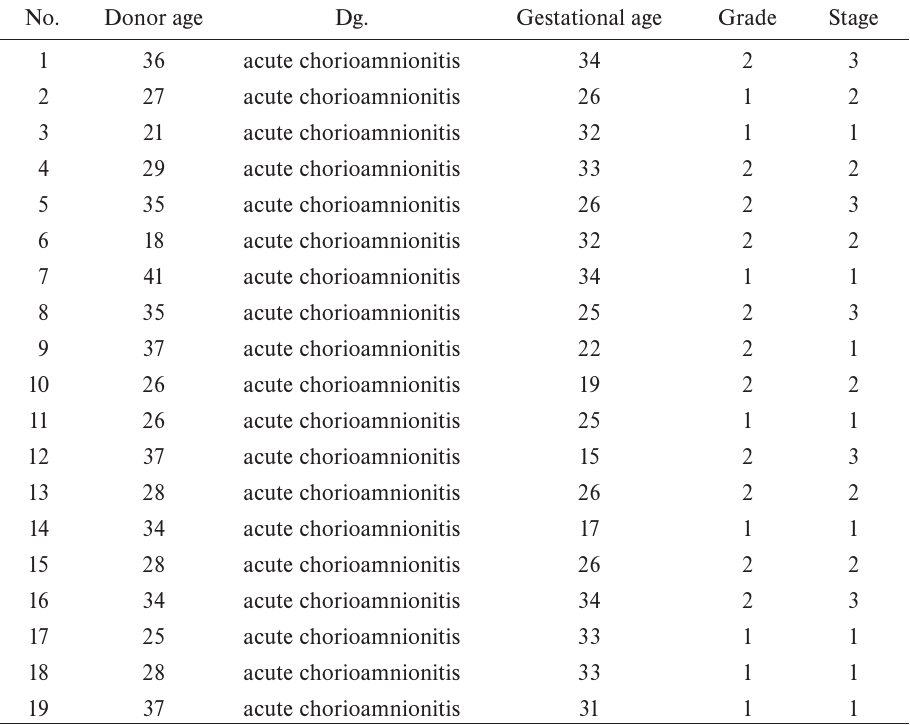
Table 1. Characterization of